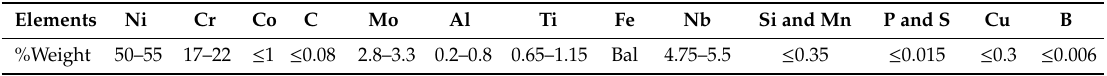
Table 1. Chemical composition in weight percentage of Inconel 718.